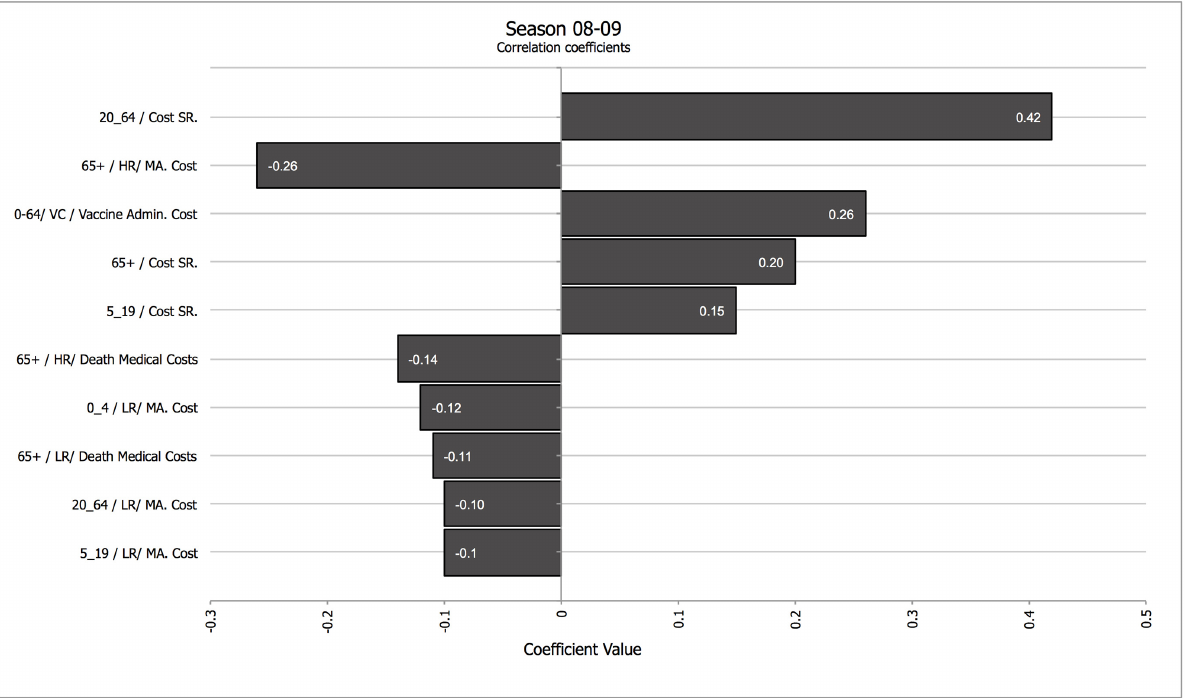
Fig 2. Tornado coefficient for Net Costs (all age cohorts, payer perspective) for season 08 – 09. Correlation coefficients in the horizontal axis. Abbreviations: Cost SR. – Cost of Systemic Reaction; HR — High Risk; LR — Low Risk; MA — Medically Attended. When applicable, the numbers in the left of the factor represent the age cohort the costs refer to. Components with correlation values < 0.1 were not